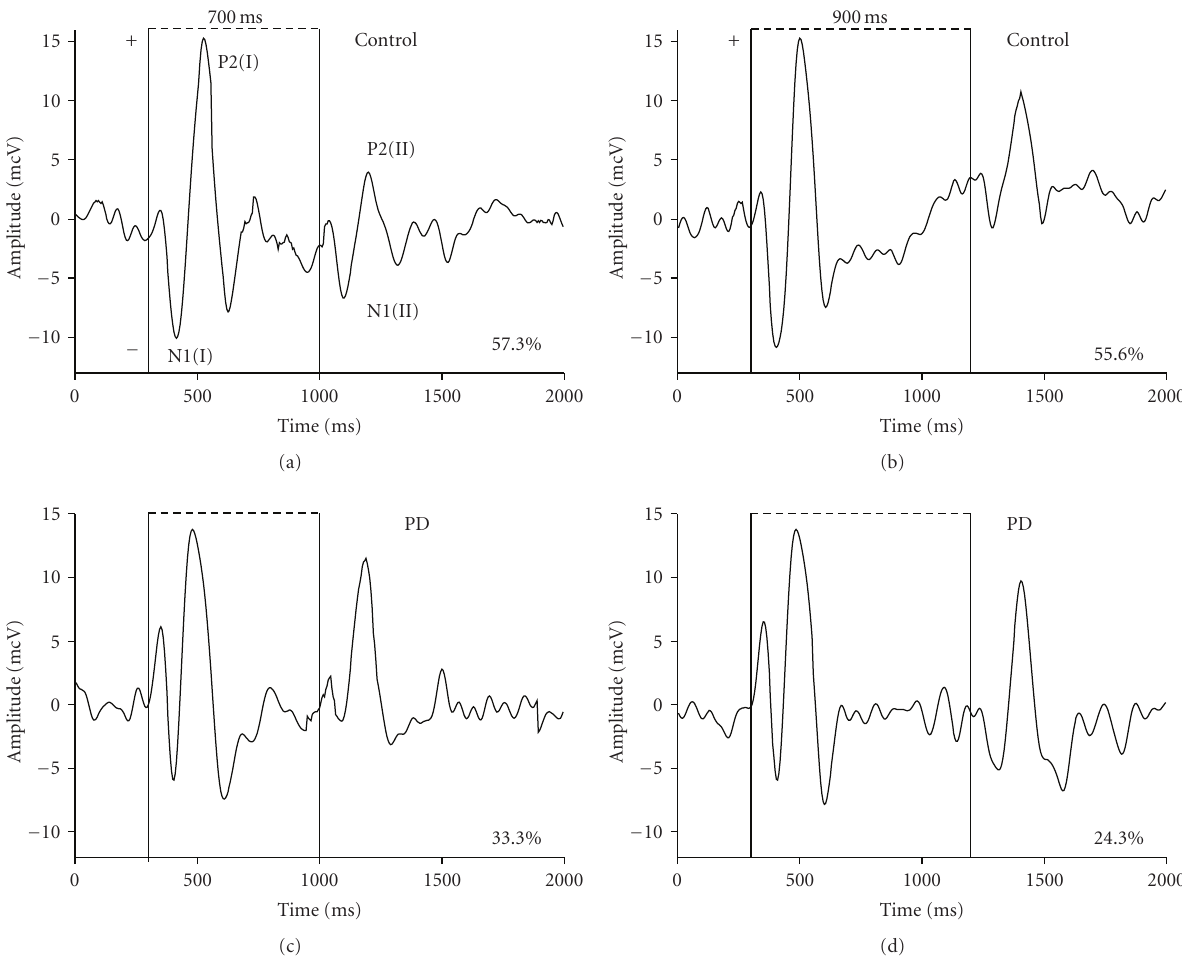
Figure 1: Cortical auditory evoked potentials at paired-pulse stimulation with interstimulus intervals 700 and 900ms in the age-matched healthy subject and in the patient with Parkinson’s disease (PD). N1 (I), P2 (I)—the components of evoked potentials on the first conditional and N1 (II), P2 (II)—on the second test stimuli. In the PD patient, the N1-P2 complexes appearing on second stimuli have greater amplitudes, hence the postexcitatory inhibition is reduced compared to control subject. Vertical solid bars correspond to the onset of auditory signals. Numerals in % represent value of paired-pulse inhibition calculated using the following formula: (A1 − A2)/A1 ∗ 100 where A1 and A2 are amplitudes of the N1 (I)/ P2 (I) and N1 (II)/ P2 (II) components,